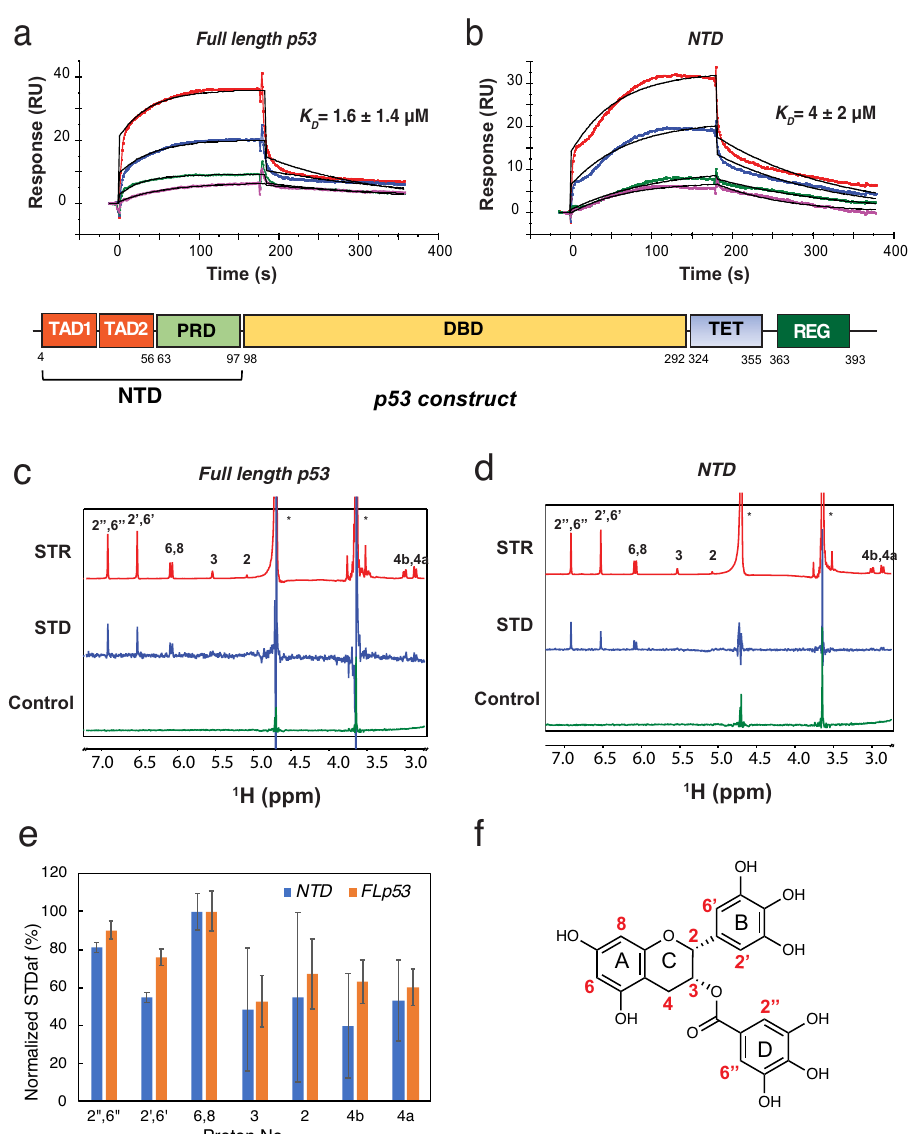
Fig. 1 EGCG binds full-length p53 and NTD with similar af fi nity and binding sites, determined by SPR and STD NMR. a SPR sensorgrams and binding af fi nity of full length p53 – EGCG interaction. Full-length p53 was immobilized on the sensor chip and the concentrations of EGCG (from top to bottom) were 10, 5, 1, and 0.5 μ M, respectively. The black curves are the fi t curves using models from BIAevaluation 4.0.1. Chi 2 (a measure of the average deviation of the experimental data from the fi tted curve) = 2.0. b SPR sensorgrams and binding af fi nity of p53 NTD – EGCG interaction. P53 NTD was immobilized on the sensor chip and the concentrations of the EGCG (from top to bottom) were 10, 5, 1, and 0.5 μ M, respectively. Chi 2 = 0.7. Domain organization of p53 is shown below the SPR sensorgrams. c Saturation transfer reference (STR) (red) and saturation transfer difference (STD) (blue) spectra of 1 mM EGCG in the presence of 10 μ M p53 NTD, and negative control (green, STD NMR of EGCG without NTD protein). d STR (red) and STD (blue) spectra of 1 mM EGCG in the presence of 5 μ M full-length p53. Asterisks denote peaks due to H 2 O ( δ = 4.7 ppm) and tris (hydroxymethyl) aminomethane ( δ = 3.7 ppm) buffer. e Bar graph of normalized STD ampli fi cation factor (STD af ) plotted against assigned protons on EGCG. Data are presented as the average of multiple scans ( n = 256) and error bars represent standard error estimated by the signal to noise ratio. Source data are provided as a Source Data fi le. f Chemial structure of EGCG and proton